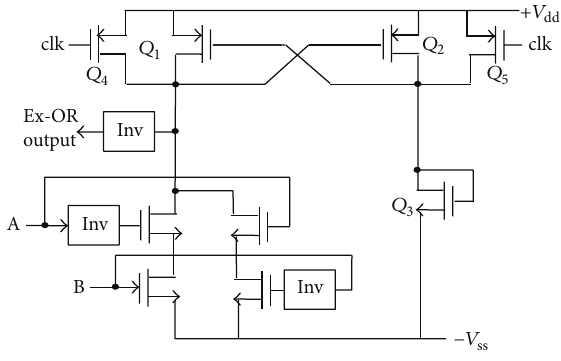
Figure 7: Schematic of two-input Ex-OR gate.